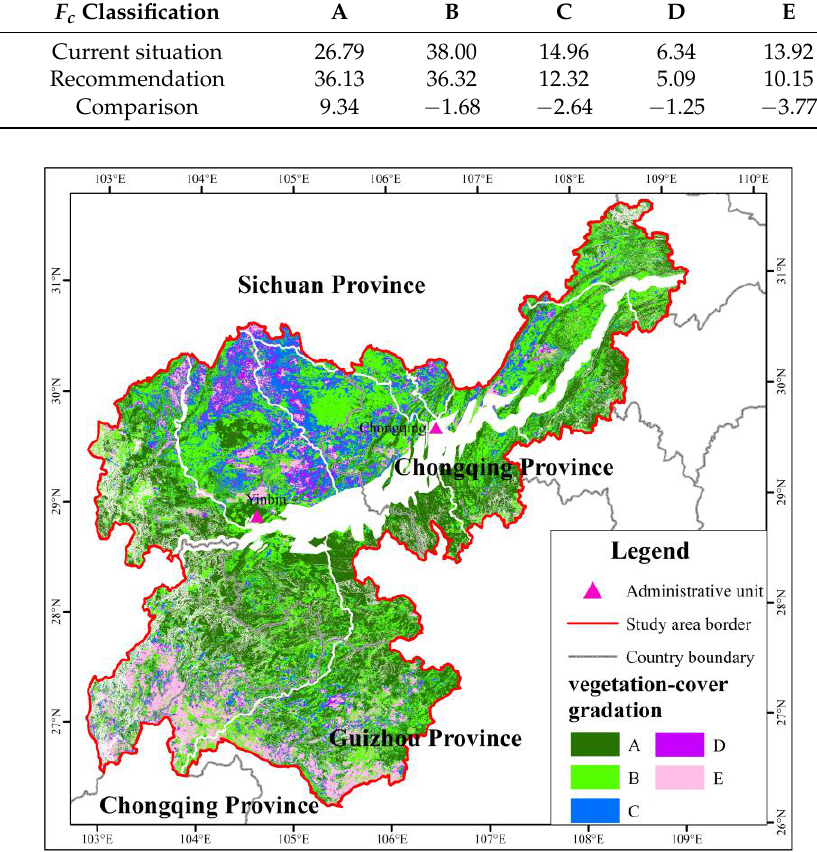
Figure 14. F c Classification of ecological barrier construction under recommended program.